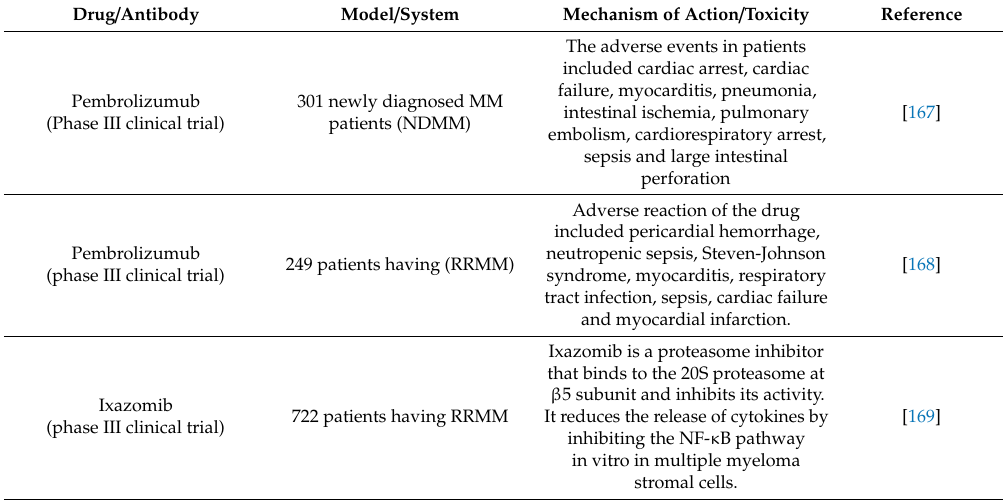
Table 2. Mechanism of action and / or toxicities of di ff erent drugs in MM patients. Drug / Antibody Model /